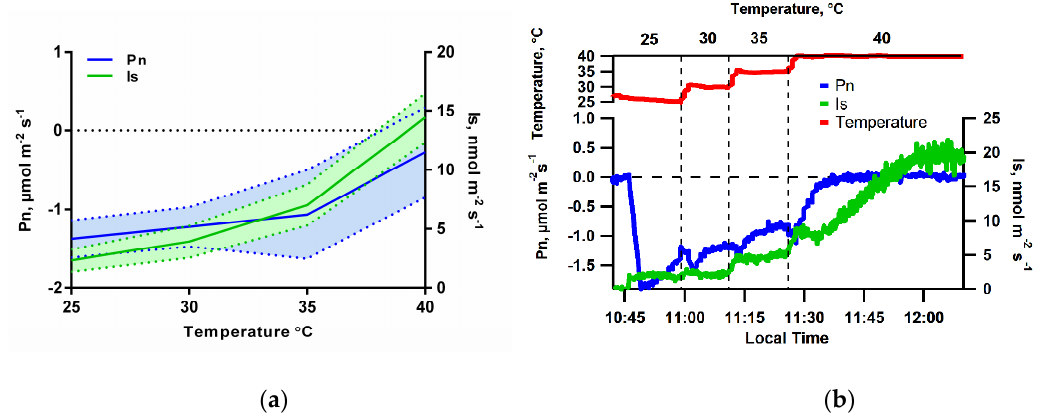
Figure 5. ( a ) Leaf isoprene emissions ( Is , nmol m −2 s −1 ) and net photosynthesis rates ( Pn , µmol m −2 s −1 ) from I. edulis leaves as a function of temperature under constant PPFD (1000 µmol m −2 s −1 ) and CO 2 -free atmosphere (0 µmol mol −1 ); the solid lines are the averages and the hatching area the standard deviation ( n = 3). ( b ) Example of leaf isoprene emissions ( Is , nmol m −2 s −1 ) measured by PTR-MS and net photosynthesis rates ( Pn , µmol m −2 s −1 ) from an I. edulis leaf under constants PPFD intensity (1000 µmol m −2 s −1 ) and CO 2 -free atmosphere, as a function of time with temperature increases at the marked intervals.